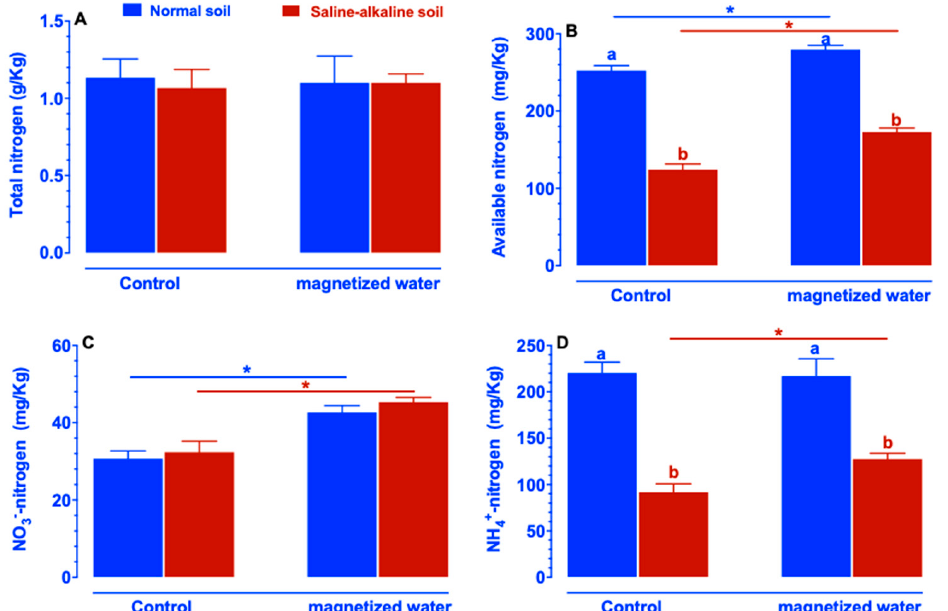
Figure 9. Effects of magnetized water on total nitrogen content ( A ), available nitrogen content ( B ), NO 3 − -nitrogen content ( C ), NH 4+ -nitrogen content ( D ) in soil. Soil samples were measured after treatment with magnetized water for five days. Means with different letters are significantly different ( p < 0.05) within the same treatment. Asterisks indicate significant differences between control and saline–alkaline stress of the same genotype, as determined by Student’s t -test (* p < 0.05).